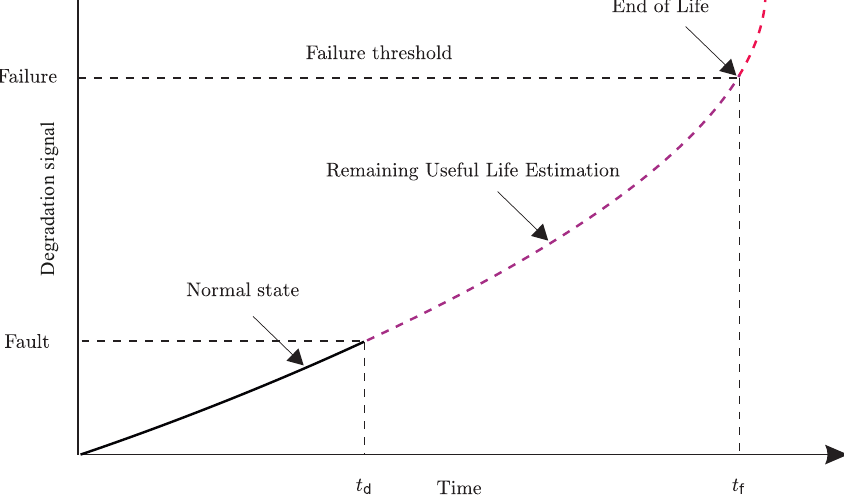
Figure 2. Concept of Remaining Useful Life (RUL).